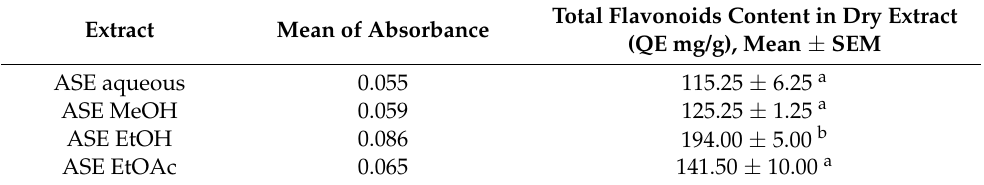
Table 4. Total flavonoids content (as QE) in M. speciosa ASE leaf extracts obtained from various extraction